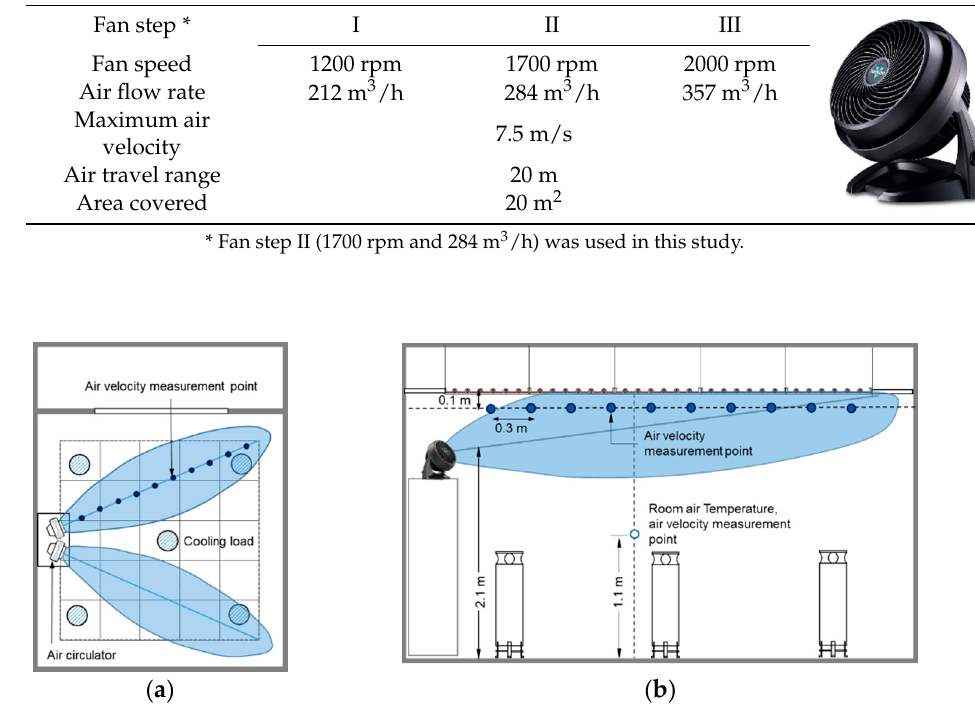
Table 2. Specifications of the air circulator.